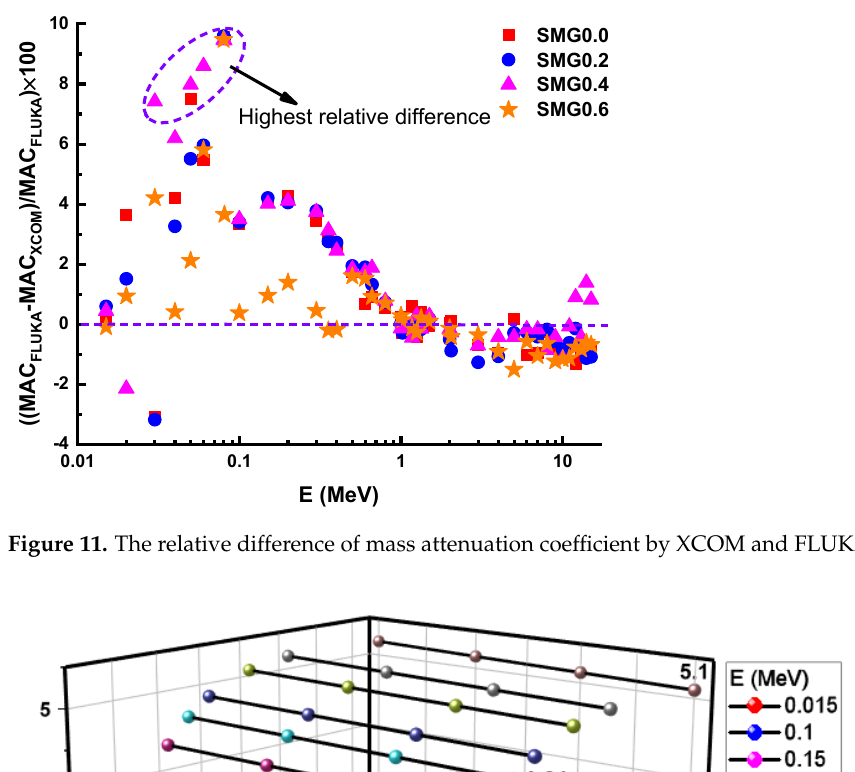
Figure 10. Mass attenuation coefficient by FLUKA and XCOM as a function of glass wt.% and pho- ton energy.